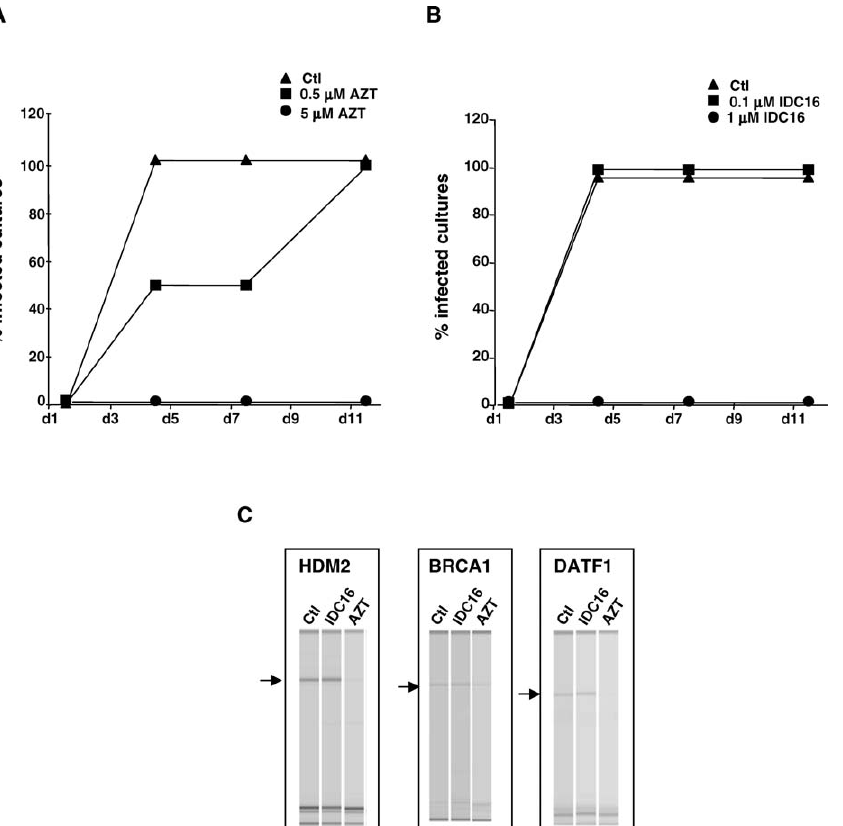
Figure 6. Comparison of HIV-1 Inhibition in MT2 Cells Treated with AZT or IDC16 and Analysis of Splicing Profiles of Apoptotic Genes in PBMC-Treated Cells (A and B) MT2 cells cultured in a 96-well plate were infected with pNL4.3 at 100 TCID 50 in the absence or presence of IDC16 (A) or AZT (B) for 18 h. Cells were then washed and changed to fresh medium with/without IDC16 or AZT. Half of the culture medium was refreshed each 2 or 4 d in the presence of drugs. The formation of syncytia was scored at the indicated time points. (C) Four ug of total RNA from triplicate of PBMCs untreated (lane Ctl) or treated with IDC16 (lane IDC16) or AZT (lane AZT), was reverse transcribed with Omniscript reverse transcriptase (QIAGEN) using random hexamers and oligo dT and. The mixture was aliquoted in a 96-well plate and subjected to PCR amplification using 0.375U/15 l l of hotStarTaq DNA Polymerase with specific primers (0.3–0.6 l M) using the buffer provided by the manufacturer (QIAGEN). The PCR reaction was carried out in a GeneAmp 9700 PCR system. Following an incubation of 15 min at 95 8 C, and 35 cycles of 30 s at 94 8 C, 30 s at 55 8 C, and 1 min at 72 8 C, the reaction was ended with an extension step of 10 min at 72 8 C. PCR products were fractionated on a LabChip HT DNA assay station (Caliper) for quantitation and sizing. The full data can be accessed through http://www.lgfus.ca/Tazi/, username ¼ Tazi, password ¼ sc35. Three examples of genes altered by AZT treatment (HDM2), (BRCA1), and (DATF1) are